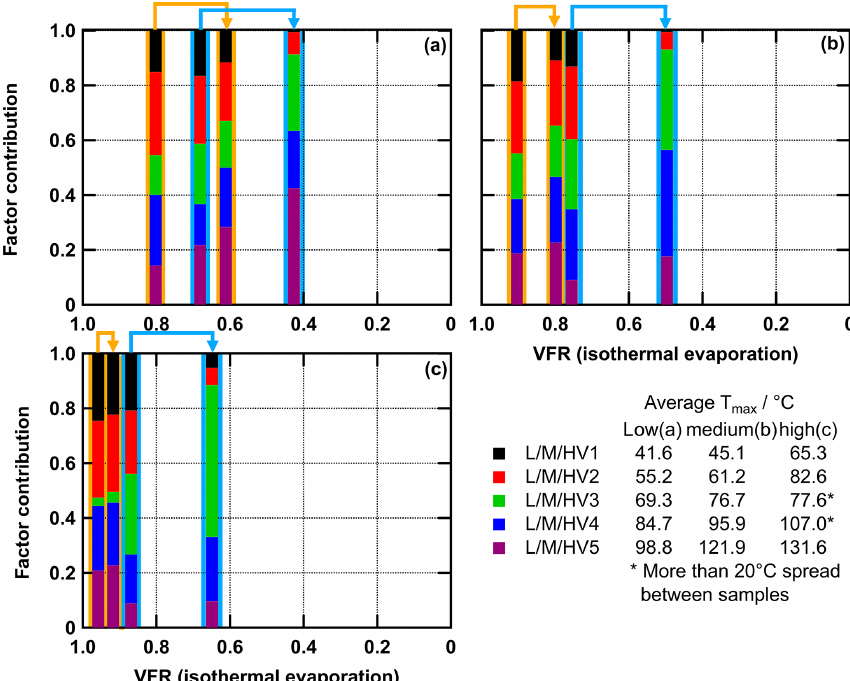
Figure 8. Contribution of type-V factors to total signal for low- (a) , medium- (b) , and high-O : C cases (c) . The x axis is the average volume fraction remaining (VFR) after comparable time intervals of isothermal evaporation observed in separate RTC experiments. Orange and blue arrows indicate the change from t evap = 0 . 25h to t evap = 4h particles for dry and wet conditions, respectively. Note that the colour code is the same in all panels, but LV1 is not equal to MV1, etc. VFR values are from isothermal evaporation measurements described in Buchholz et al. (2019). Average T max values are for the comparison of the volatility of the factors. Detailed values are given in Table